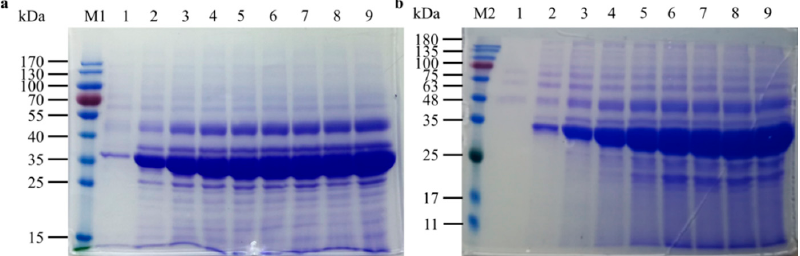
Figure 5. Time course of sodium dodecyl sulfate polyacrylamide gel electrophoresis (SDS-PAGE) analyses of extracellular proteins during high-density cultivation in a 3 L fermenter of the following